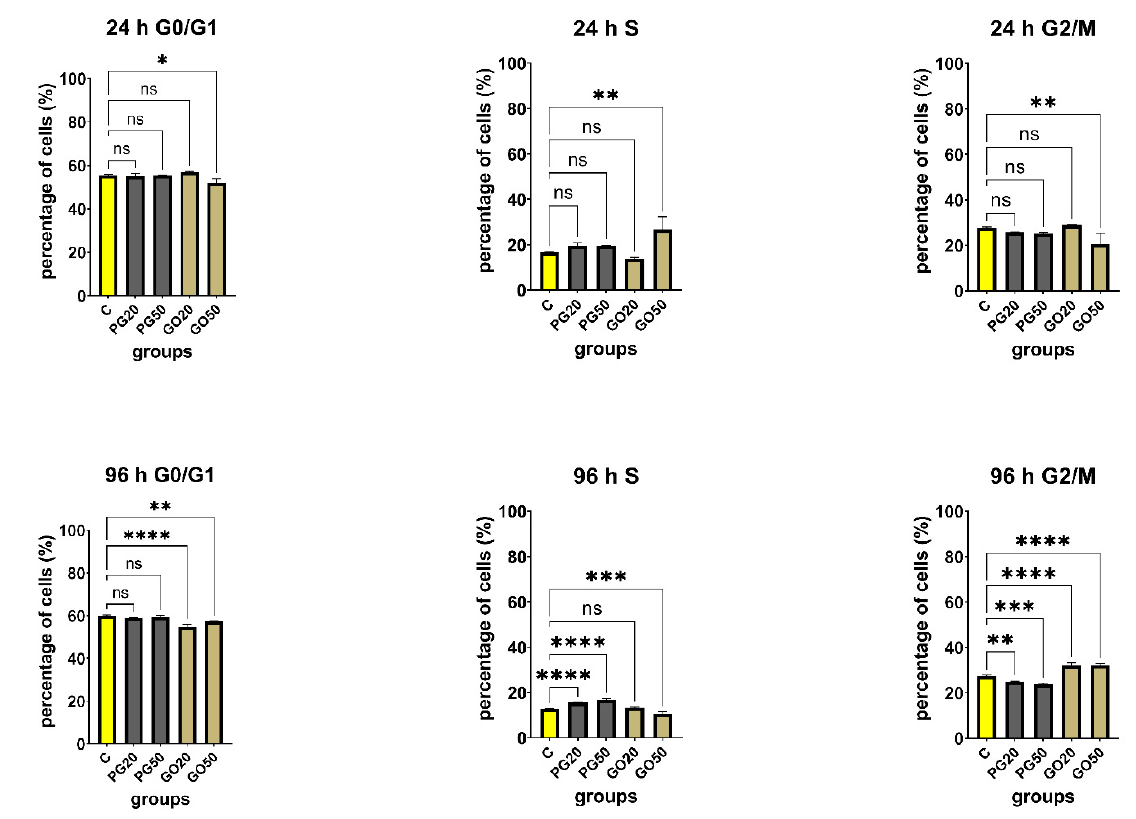
Figure 15. Cell cycle in Hs-5 cells untreated and treated with PG and GO flakes as evaluated by flow cytometry and propidium iodide (PI). The charts show the percentage of cells in individual phases of the cell cycle at all tested concentrations (20 µg/mL, 50 µg/mL), compared to the control groups (untreated). Values in the rows marked with an asterisk show statistically significant differences ( p < 0.05) as compared to the control assay. Notes: G0—not dividing resting cells, cell cycle arrest; G1—preparation for division, cellular contents, excluding the chromosomes, are duplicated; S—phase synthesis DNA, each of the 46 chromosomes is duplicated by the cell; G2—the cell double checks the duplicated chromosomes for error, making any needed repairs; M—mitosis. Abbreviations: C—control group (untreated cells); PG—pristine graphene; GO—graphene oxide.